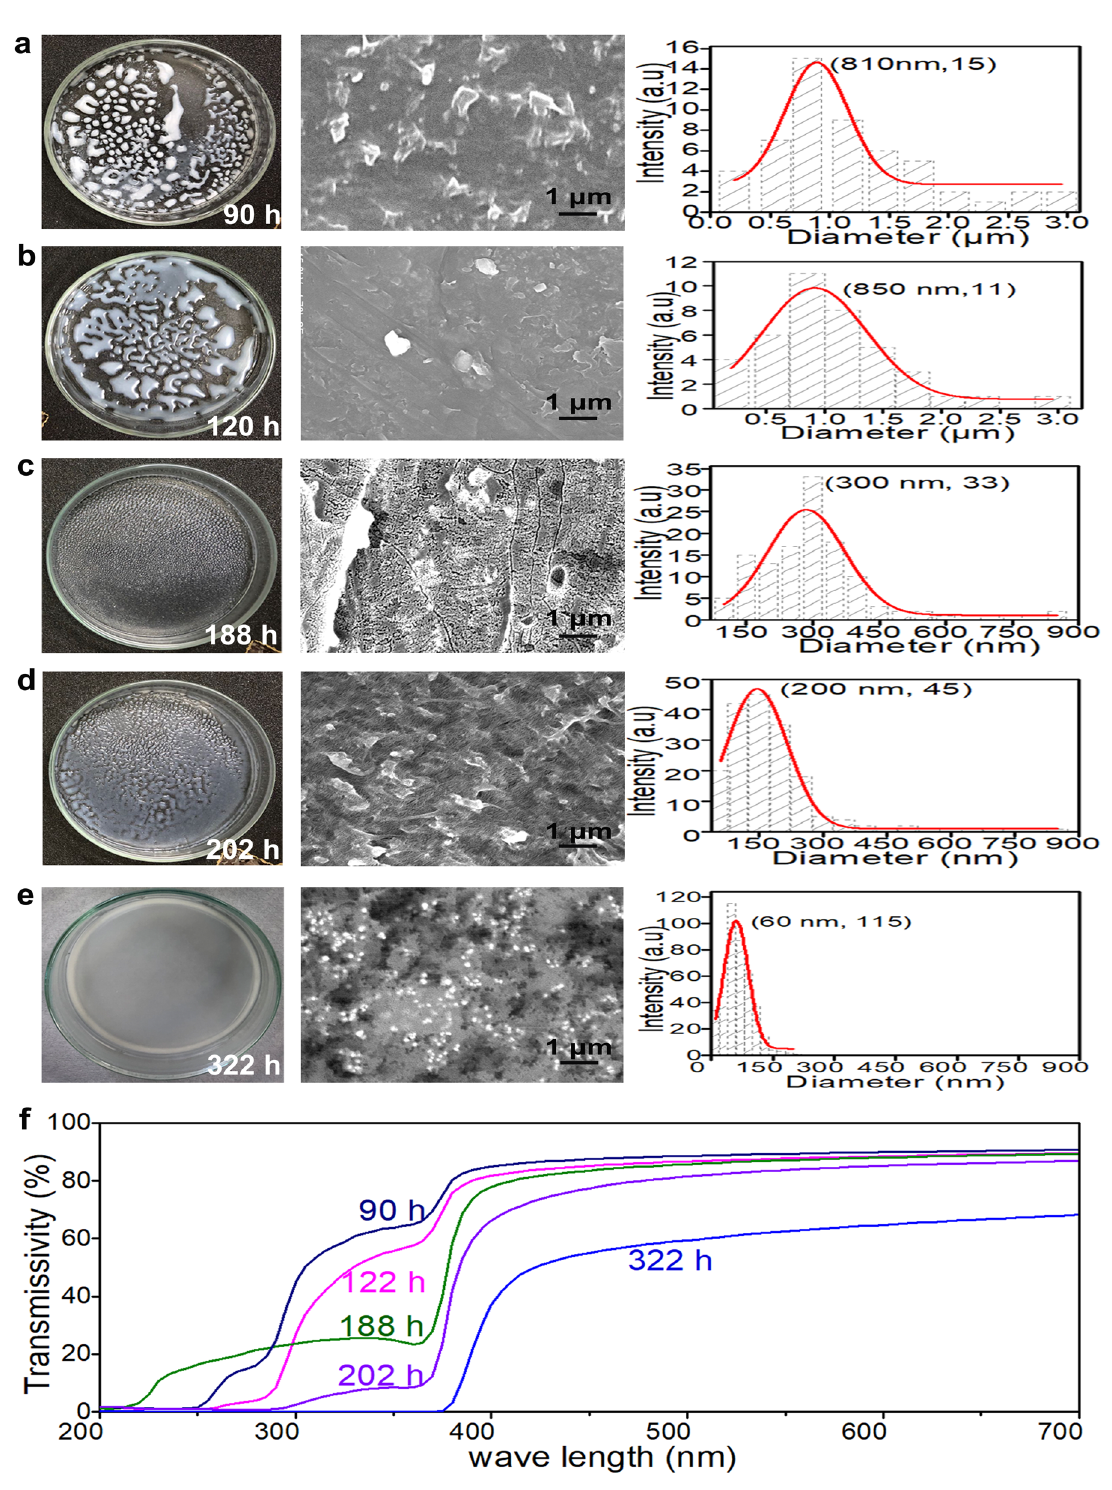
Figure 3: E ff ect of dissolution time on ZnO NP dispersion in LDPE; ( a – e ) the left column presents the ZnO/LDPE casted fi lms, the middle column presents the SEM images of the hot - pressed ZnO/LDPE fi lms, and the right column presents the corresponding particle size distributions; ( f ) the transmissivity curves of the ZnO/LDPE fi lms after the di ff erent dissolution